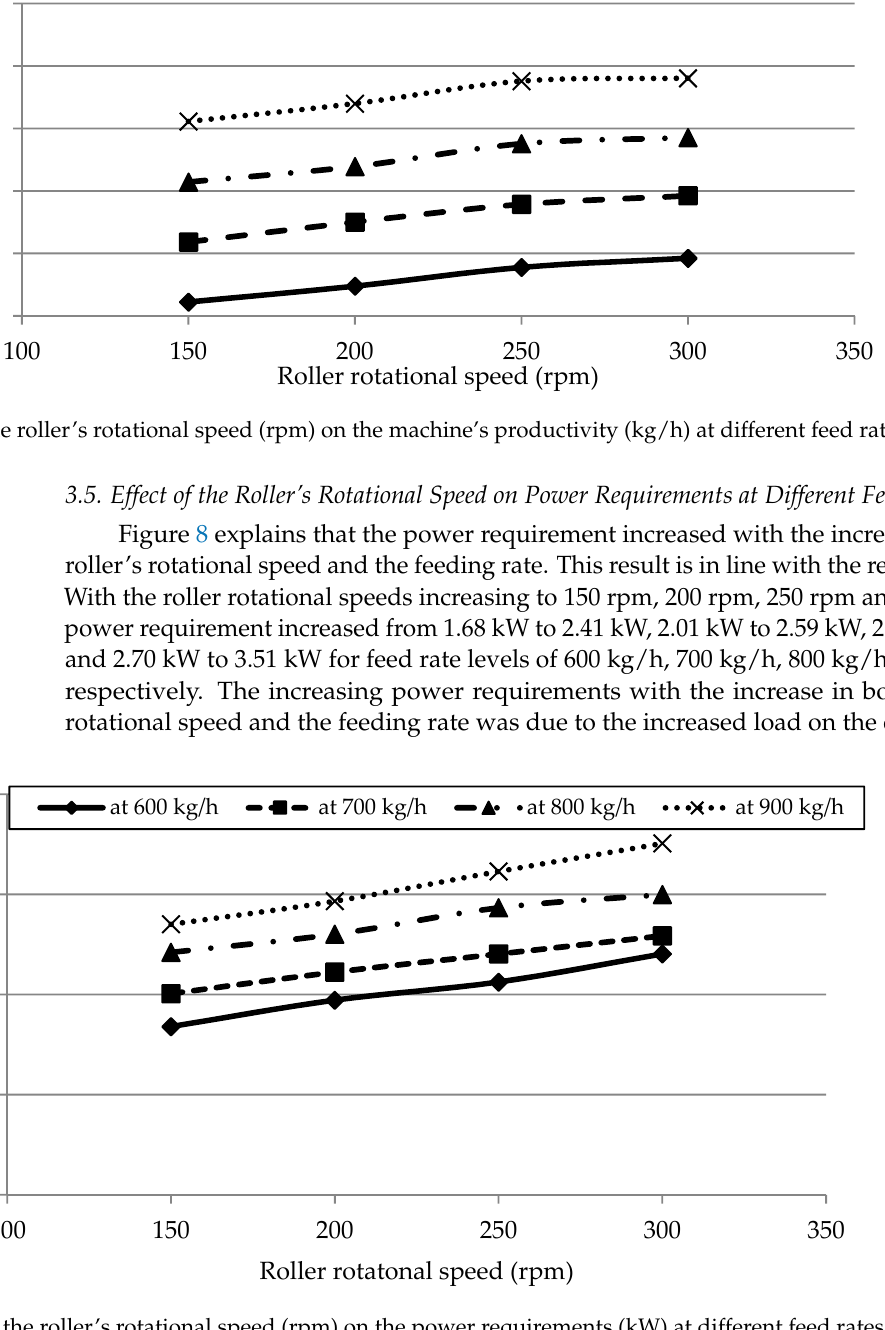
Figure 8. Effect of the roller’s rotational speed (rpm) on the power requirements (kW) at different feed rates (kg/h).